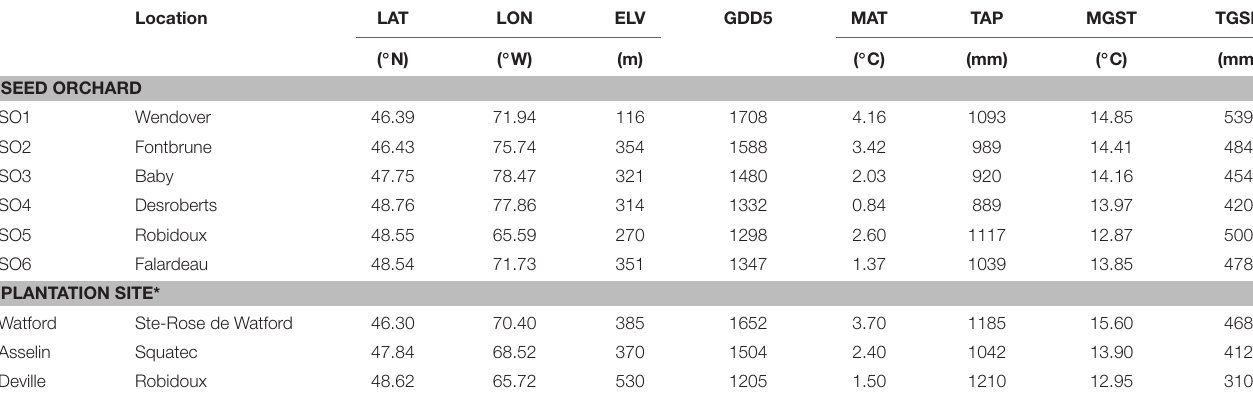
TABLE 1 | Location and climatic conditions a (over 1981–2010) of the six white spruce seed sources used in this study and the three plantation sites. Location